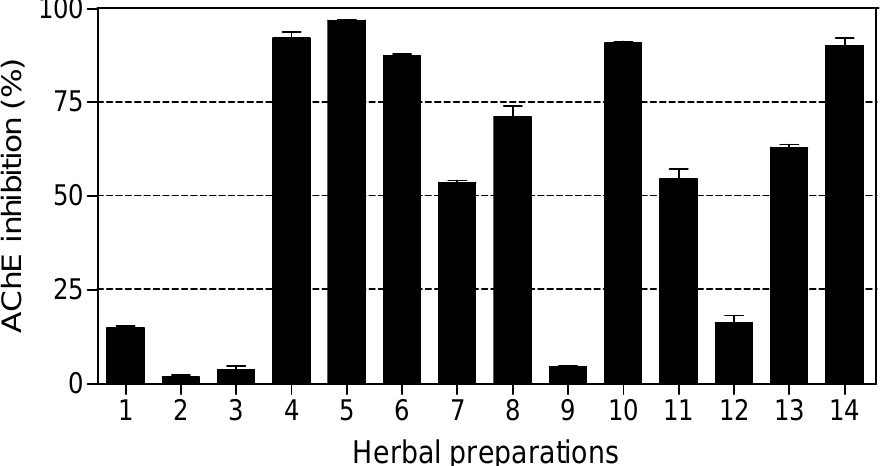
Figure 4. Percentage inhibition of AChE by commercial herbal preparations (1 mg/mL).